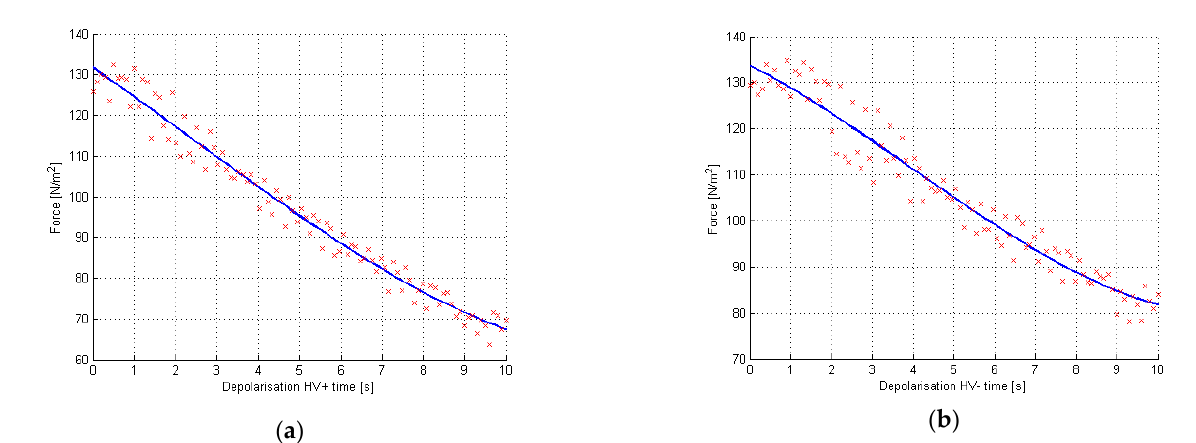
Figure 7. Dependence of the attraction force during depolarization of the electroadhesive pad under a given polarization ( a ) HV+ and ( b ) HV − .